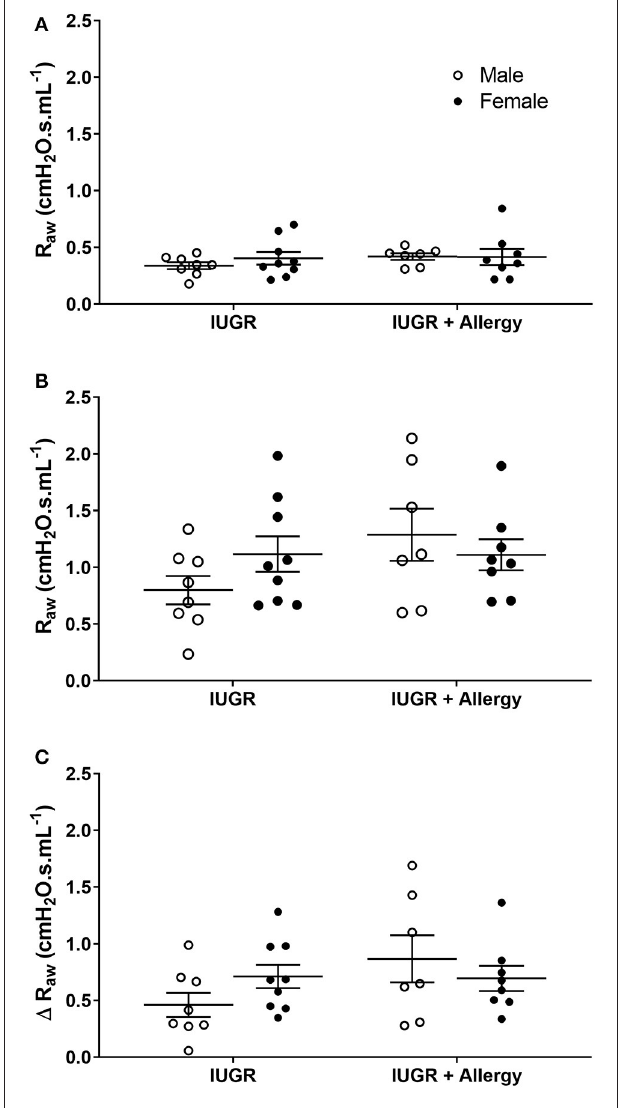
FIGURE 5 | Changes in R aw in IUGR and IUGR Allergy groups. Airway + resistance in IUGR male ( n 8) and female ( n 9), and IUGR Allergy male = = + ( n 7) and female ( n 8) offspring before (A) and after (B) MCh challenge, = = and 1 R aw (C) . Data are mean SEM. Males, open circles; Females, closed ± circles; R aw , airway resistance; IUGR, intrauterine growth restriction; MCh, methacholine; 1 , net change after MCh